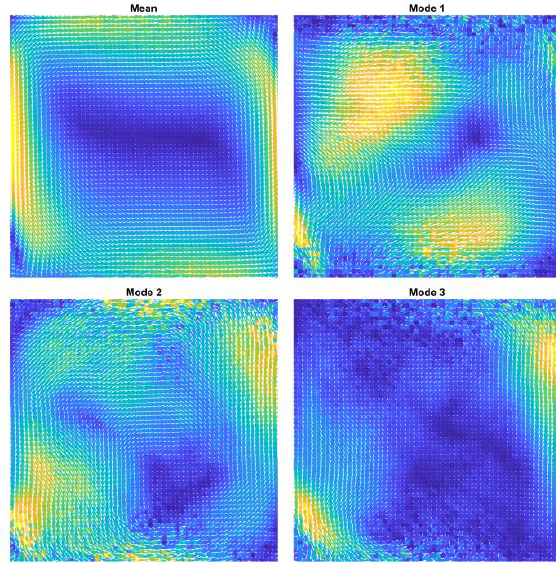
Fig. 5. Mean velocity field and 4 main POD modes, arranged by descending energy.